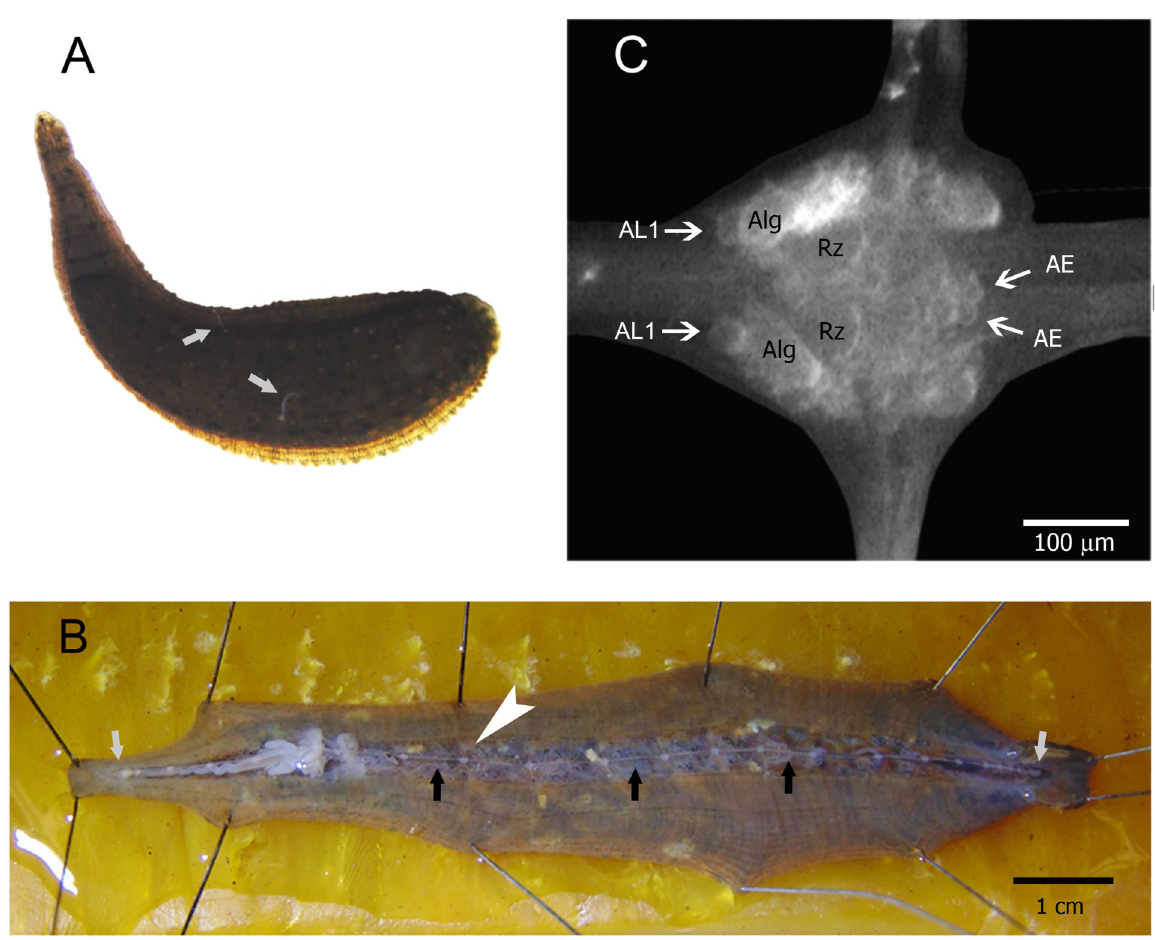
Figure 1. Central nervous system (CNS) of the Mexican leech Haementeria of fi cinalis . A , Dorsal view of an experimental animal. The head is on the left superior corner of the image and the tail is at the other end. It has 2 ventral suckers at both ends. The image shows two spermatophores (sperm bags, white arrows) deposited during fertilization. B , The animal was anesthetized and pinned on wax. The CNS, consisting of a ganglion chain, was visualized after ventral incision. The chain extends from the head (left end) to the tail and includes 4 ganglia in the head and 7 in the tail (white arrows). The 21 intermediate ganglia are linked by connective nerves; one ganglion is shown with a white arrowhead and three connective nerves are shown with black arrows. C , Intermediate ganglion. The position of the neurons is stereotyped. The Retzius (Rz) interneurons are in the ventral area, the annulus erector (AE) motoneurons are posterior and the anterolateral number 1 (AL1) neurons are located anteriorly to the giant anterolateral neurons